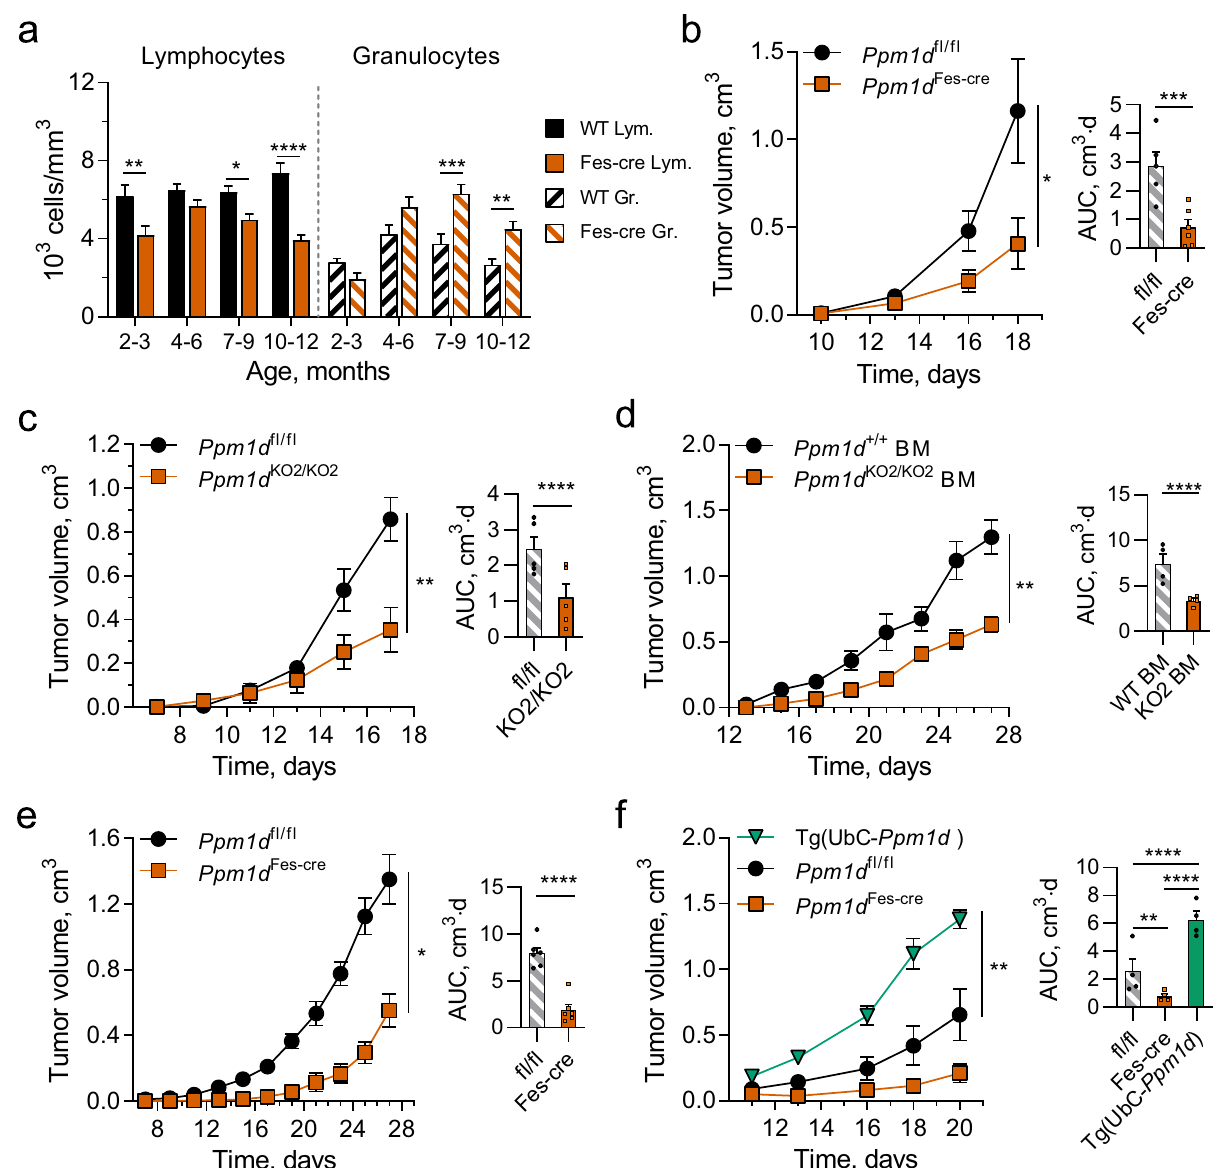
Fig. 1 Wip1 de fi ciency in hematopoietic cells suppresses the growth of solid tumors. a Age-strati fi ed lymphocyte and granulocyte numbers in peripheral blood of Ppm1d fl / fl and Ppm1d Fes-Cre ( Ppm1d fl / fl ;Fes-Cre) mice ( n = 12 each genotype). b Tumor volume (left) and tumor growth area under the curve (AUC) (right) for growth of B16 F10 melanoma in Ppm1d fl / fl ( n = 5) and Ppm1d Fes-Cre ( n = 6) mice. c Tumor volume (left) and AUC (right) for growth of B16 F10 tumors in Ppm1d fl / fl and Ppm1d KO2/KO2 ( n = 5 each genotype). d Tumor volume (left) and AUC (right) for growth of B16 F10 tumors in lethally irradiated WT mice with subsequent adoptive transfer of WT or Ppm1d KO2/KO2 bone marrow (BM) cells ( n = 4 each genotype). e Tumor volume (left) and AUC (right) for growth of LLC1 lung carcinoma tumors in Ppm1d fl / fl and Ppm1d Δ HSC mice ( n = 6 each genotype). f Tumor volume (left) and AUC (right) for growth of LLC1 tumors in Ppm1d fl / fl , Ppm1d Fes-Cre , and Tg(UbC- Ppm1d ) mice ( n = 4 each genotype). Data are depicted as means ± SEM. Student ’ s t test (two-tailed) ( b – e ), ordinary one-way ANOVA ( f ), and ordinary one-way ANOVA with Sidak ’ s multiple comparison test ( a ): * p < 0.05; ** p < 0.01; *** p < 0.001; **** p < 0.0001 (one representative experiment out of 3 is shown for Panel b – f ). Source data are provided as a Source Excel Data fi